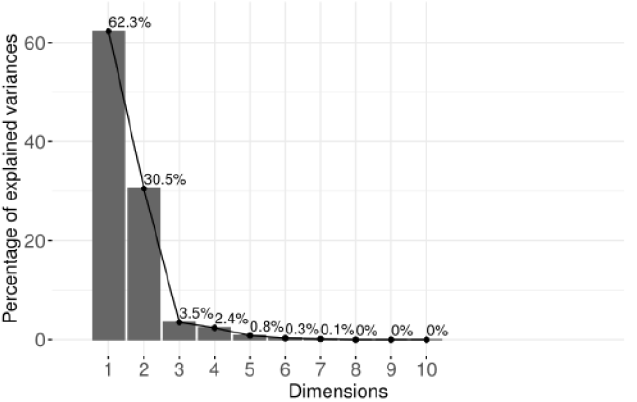
Figure 1. Scree plot of the eigenvalues of the factors with respect to the principal components obtained from the building materials dataset.